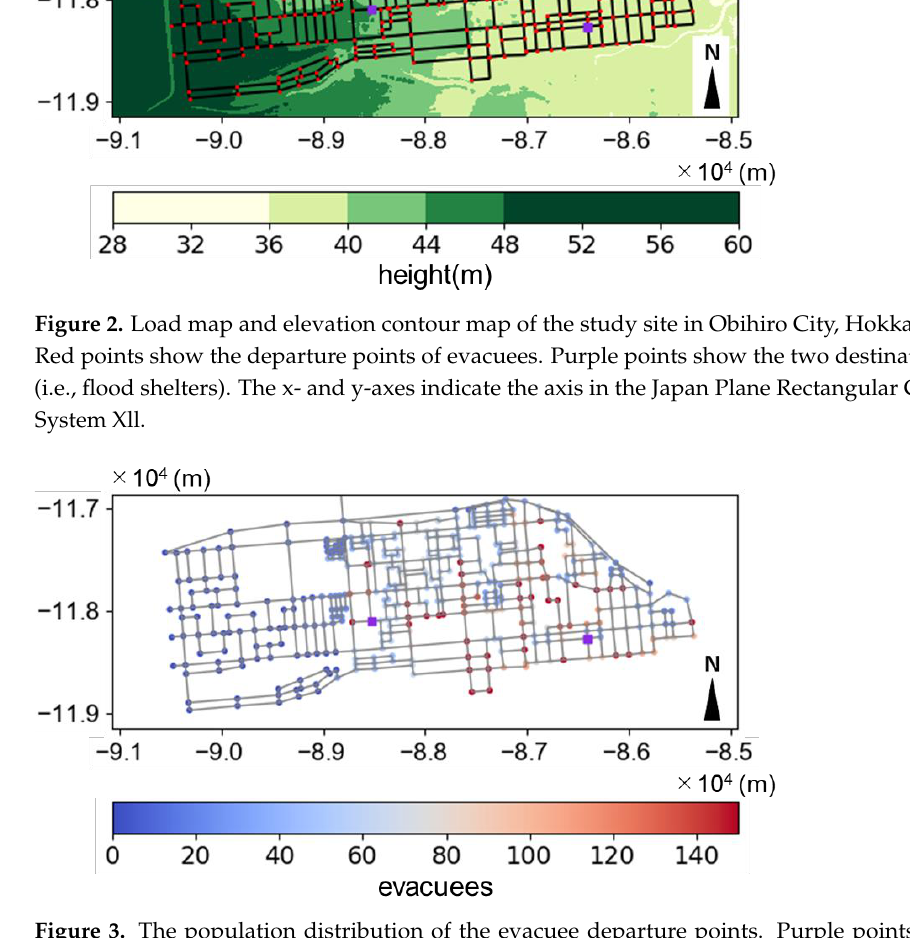
Figure 3. The population distribution of the evacuee departure points. Purple points show the two destination points (i.e., flood shelters). The x- and y-axes indicate the axis in the Japan Plane Rectangular Coordinate System Xll.